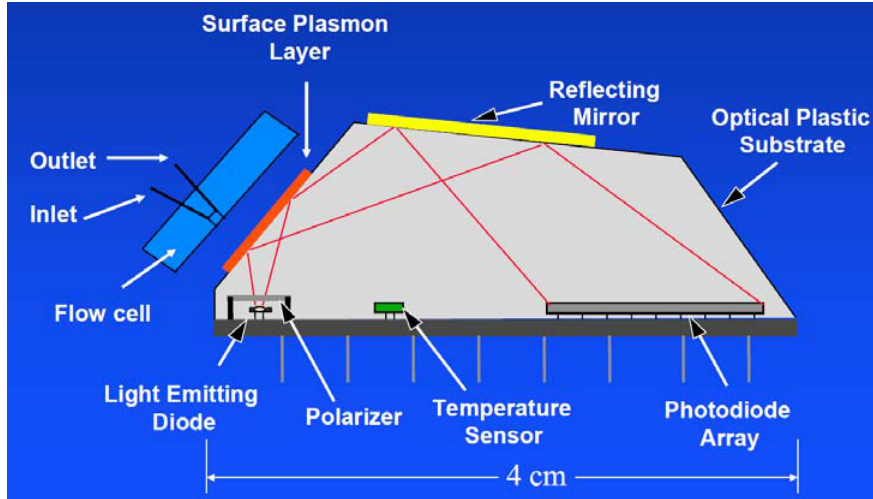
Figure 6. Miniature Surface-Plasmon Resonance (SPR) Sensor Platform (modified). Reprinted with kind permission of C. E. Furlong,